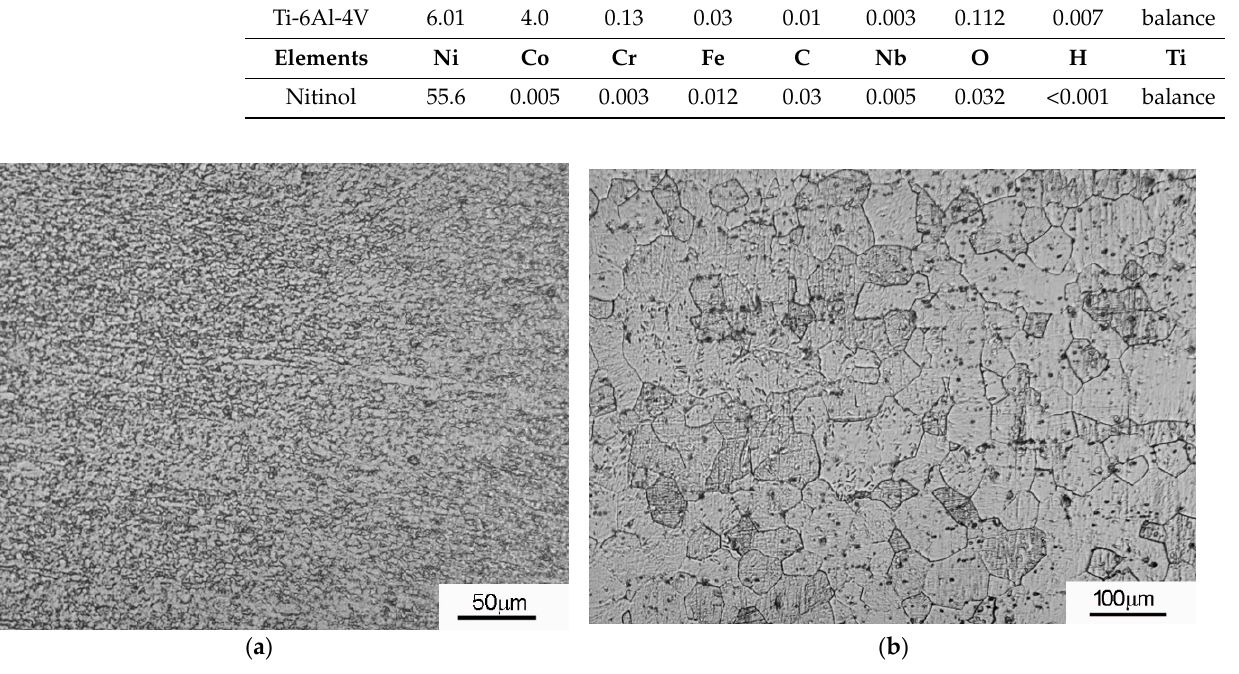
Figure 1. Optical microstructures of the base metals: ( a ) Ti-6Al-4V and ( b ) Nitinol.